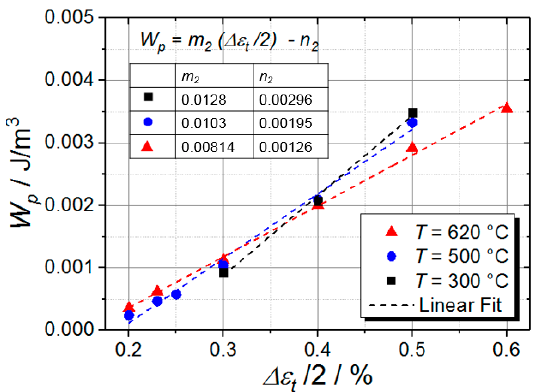
Figure 8. Relationship between the total strain amplitude and plastic work for the LCF-tests (cycles at 50% lifetime).